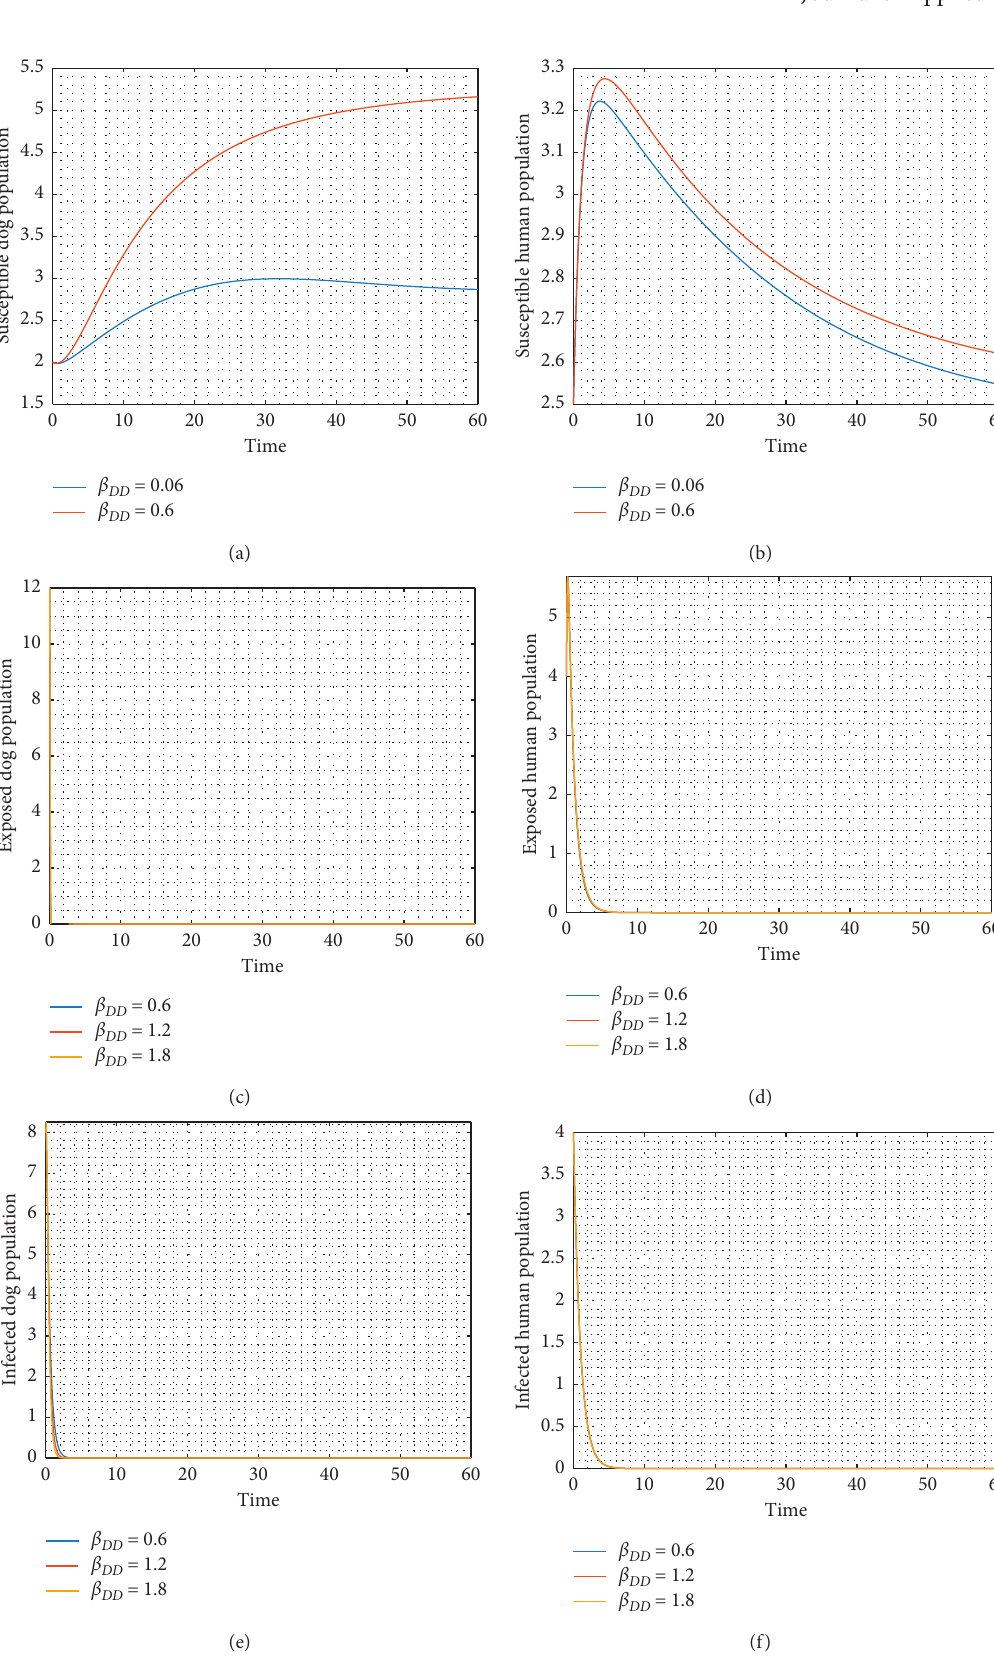
Figure 7: Solution curves of model (1) showing the effect of β